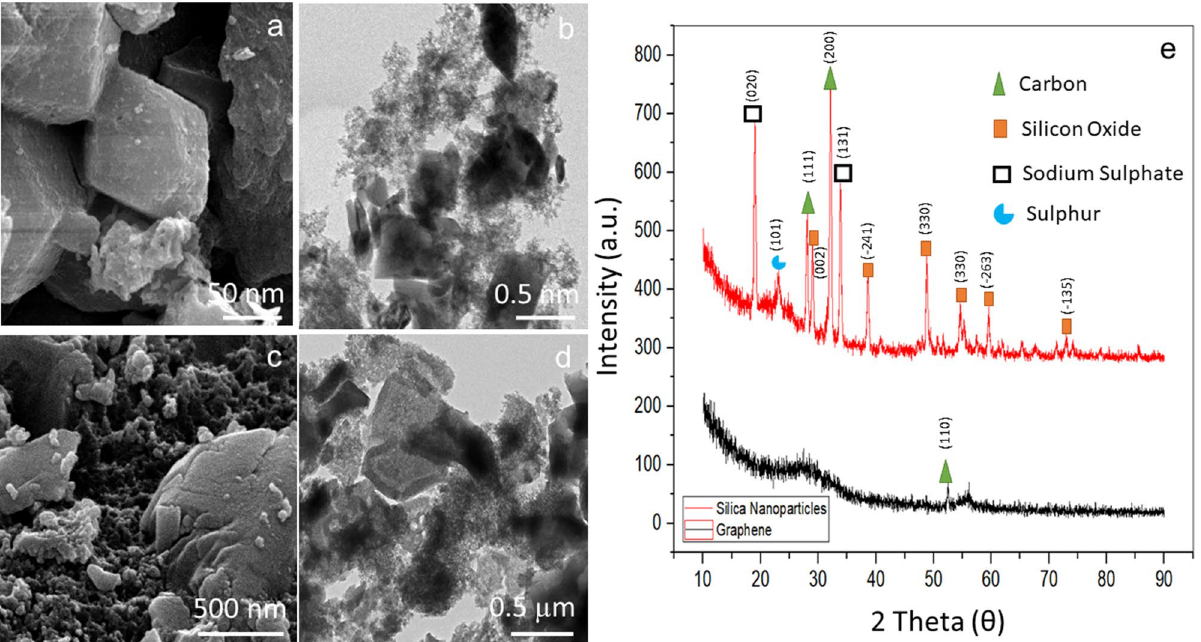
Figure 1. Morphological characterization using high resolution microscopy. Images captured for silica nanoparticles with FESEM ( a ) & FETEM ( b ); Graphene with FESEM ( c ) & FETEM ( d ). X-ray diffraction spectra ( e ). The comparison of diffraction peaks received between silica nanoparticles and graphene is